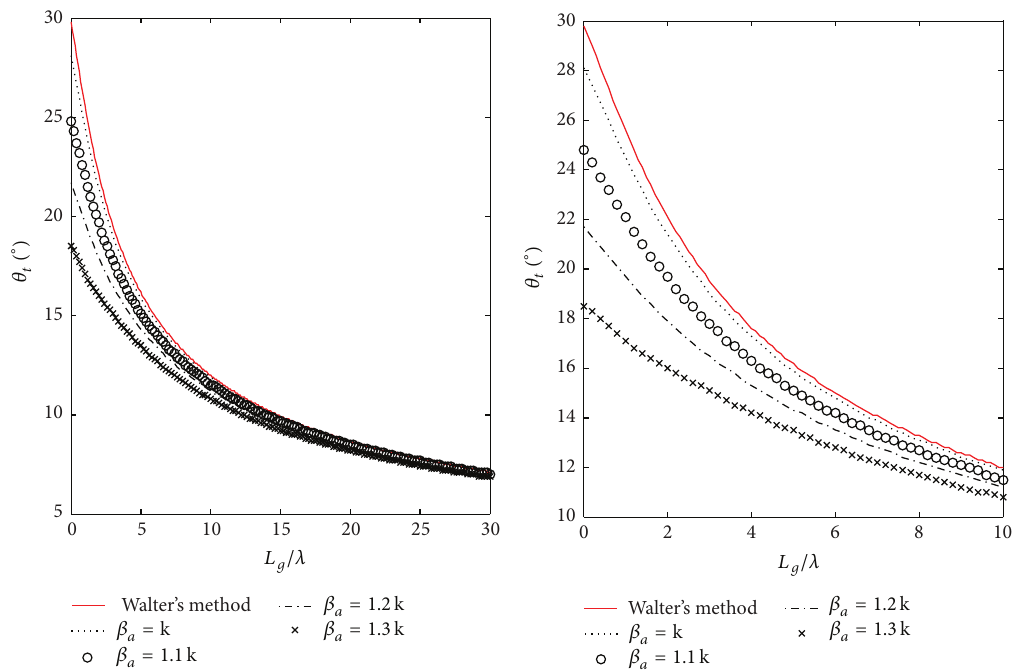
Figure 8: Estimated beam tilt angles of the 10-element monopole end-fire antenna when 𝐿 𝑎 = 2𝜆 , 𝛽 𝑎 = 𝑘, 1.1𝑘, 1.2𝑘 and 1.3𝑘 and Walter’s